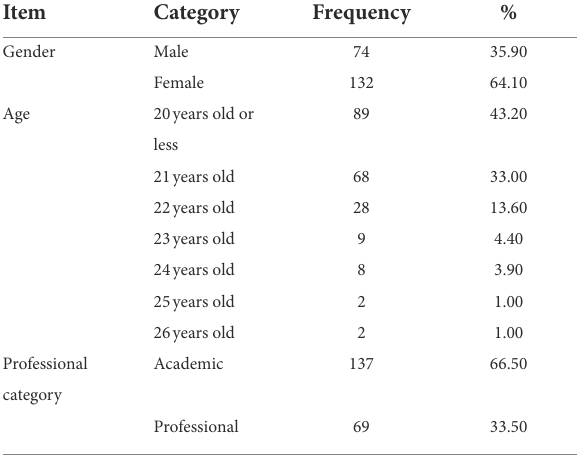
TABLE 1 Demographic profile of